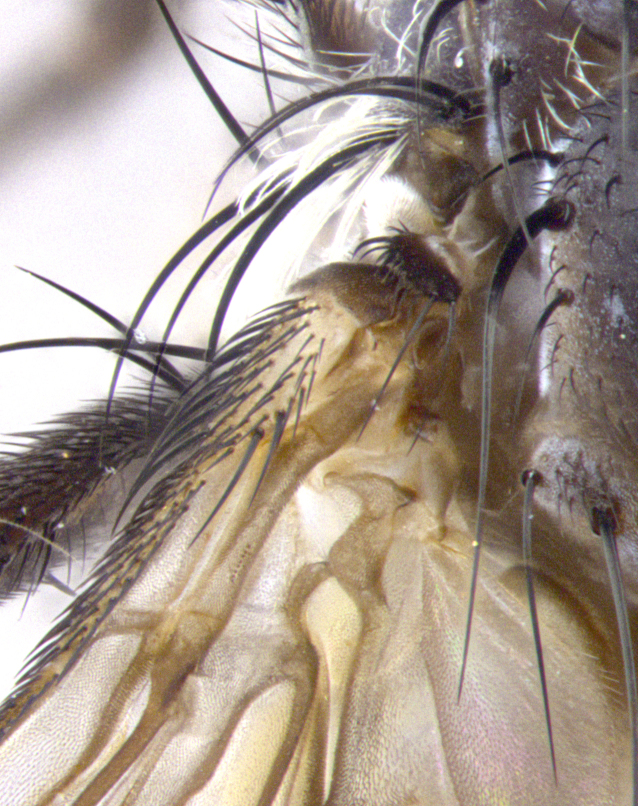
Telothyria
grisea
sp. n. displaying the brown color basicosta.